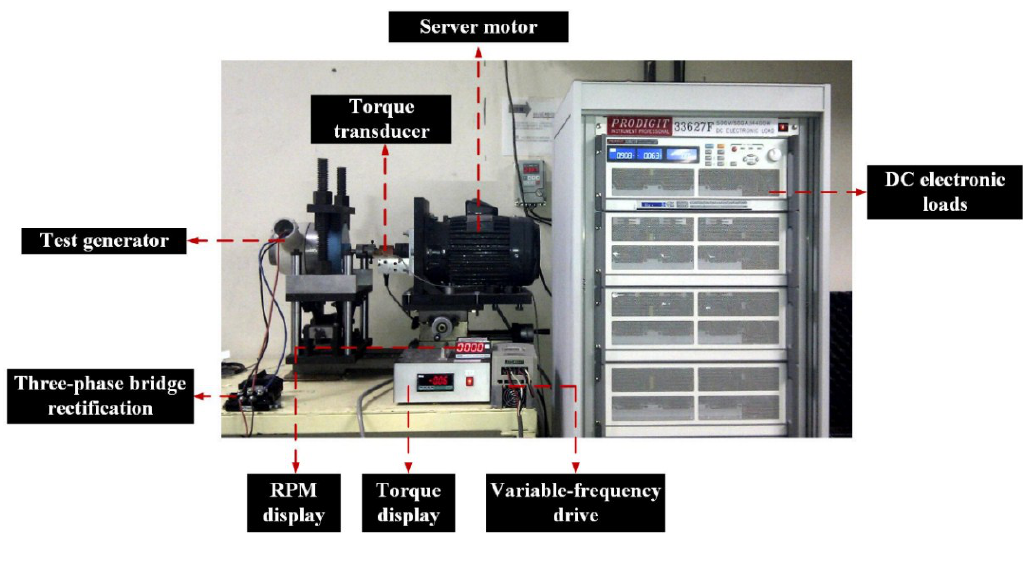
Figure 4. The generator performance test